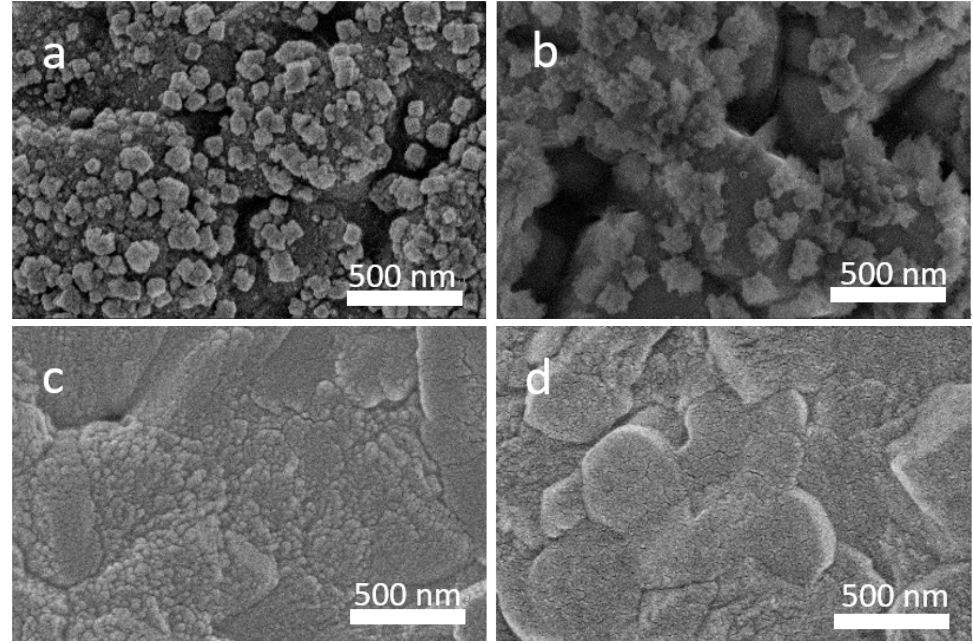
Figure 1. The images of Li 1 − x (Ni 0.5 Mn 0.3 Co 0.2 )O 2 in cathode film ( a ) 25 °C, ( b ) − 20 °C; the images of graphite in anode film ( c ) 25 °C, ( d ) − 20 °C.